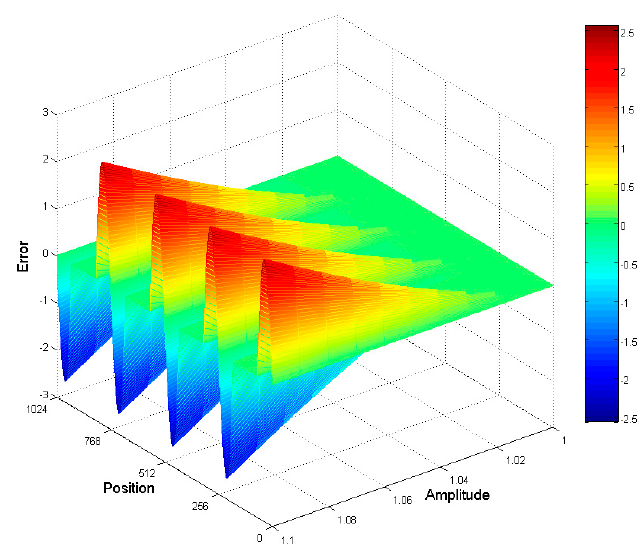
Figure 3. Subdivision error when the amplitude of the fine code signal is saturated.